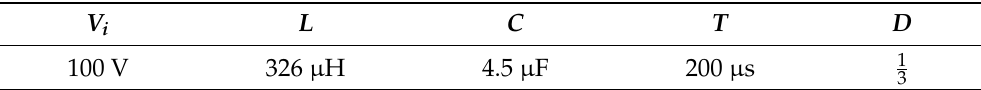
Figure 10. Bifurcation diagram of the DCM-operated boost converter with a CPL obtained using the PSIM © software. Table 5. The used parameter values for the open-loop buck and boost converters loaded by a